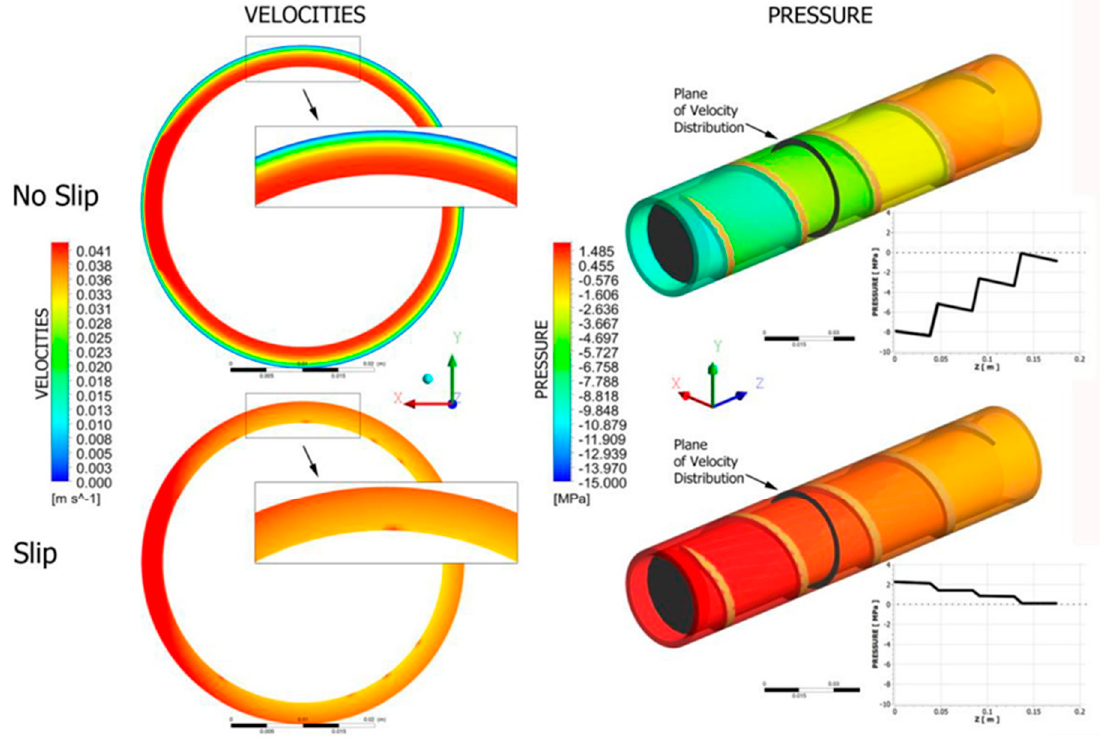
Figure 4. Screw flow simulations of single screw extruder adapted from Wilczy ń ski et al. [76].